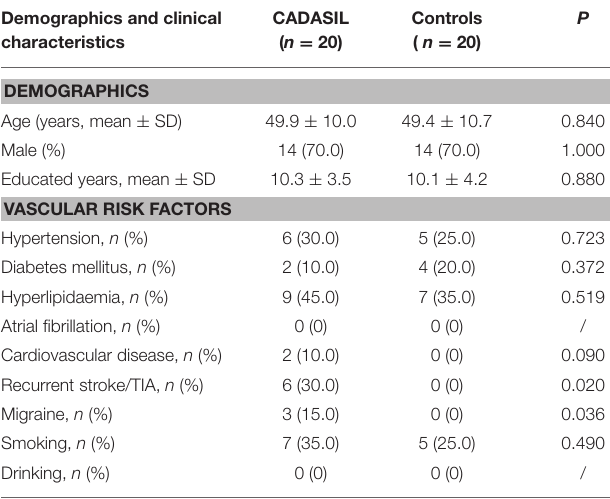
TABLE 1 | Demographics and clinical characteristics of the participants. Demographics and clinical characteristics